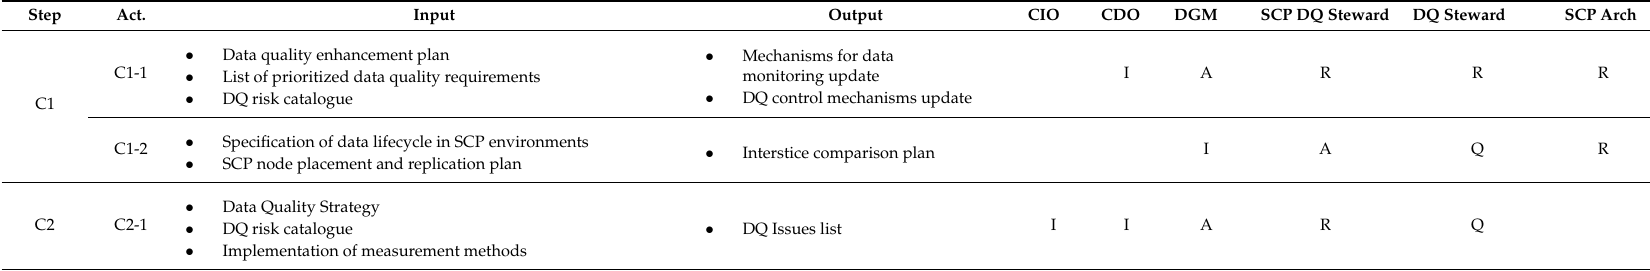
Table 7. Inputs, outputs and RACIQ matrix for the Check phase. (R—Responsible (works on); A—Accountable, C—Consulted; I—Informed; Q—Quality Reviewer). Step